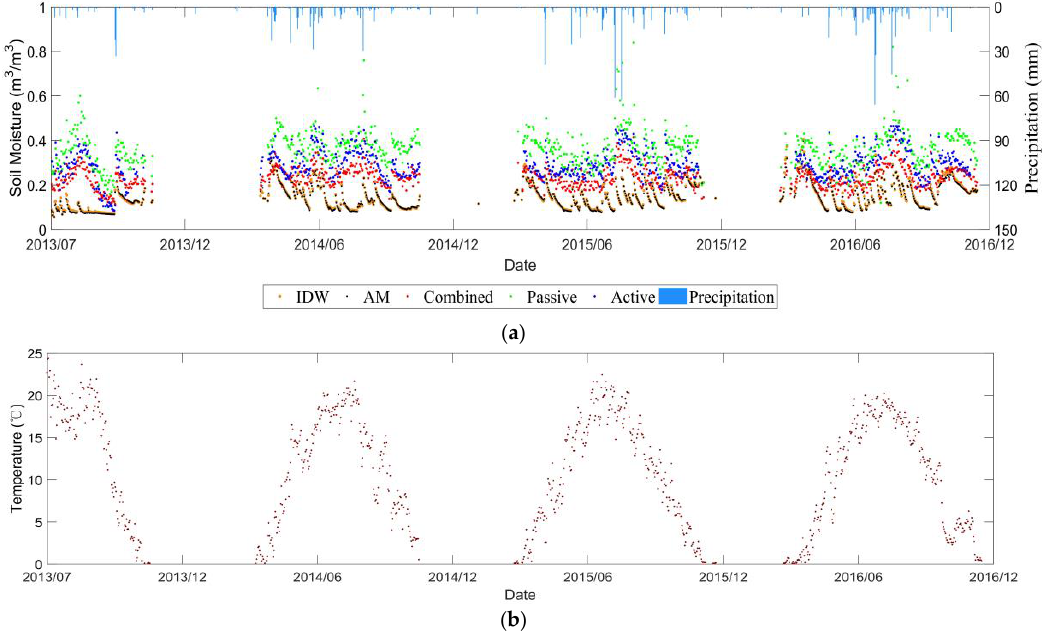
Figure 11. Temporal evolutions of ( a ) CCI retrieved and in-situ measured soil moisture ( b ) temperature over Manitoba site in the RISMA network.